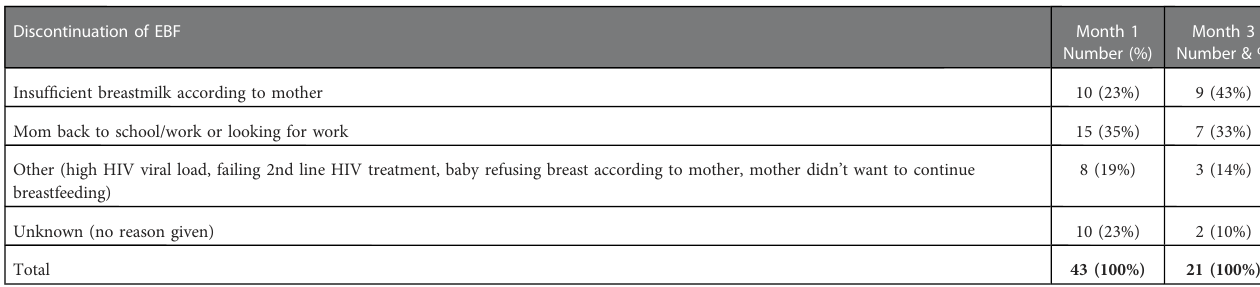
TABLE 2 Reason given for cessation of breastfeeding at 1 and 3 month ’ s